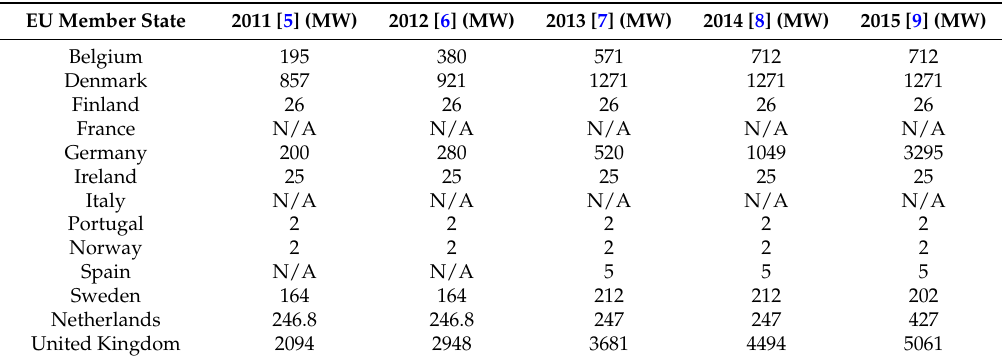
Table 1. Offshore wind capacity installed—cumulative share by country for 2011–2015 according to the European Wind Energy Association